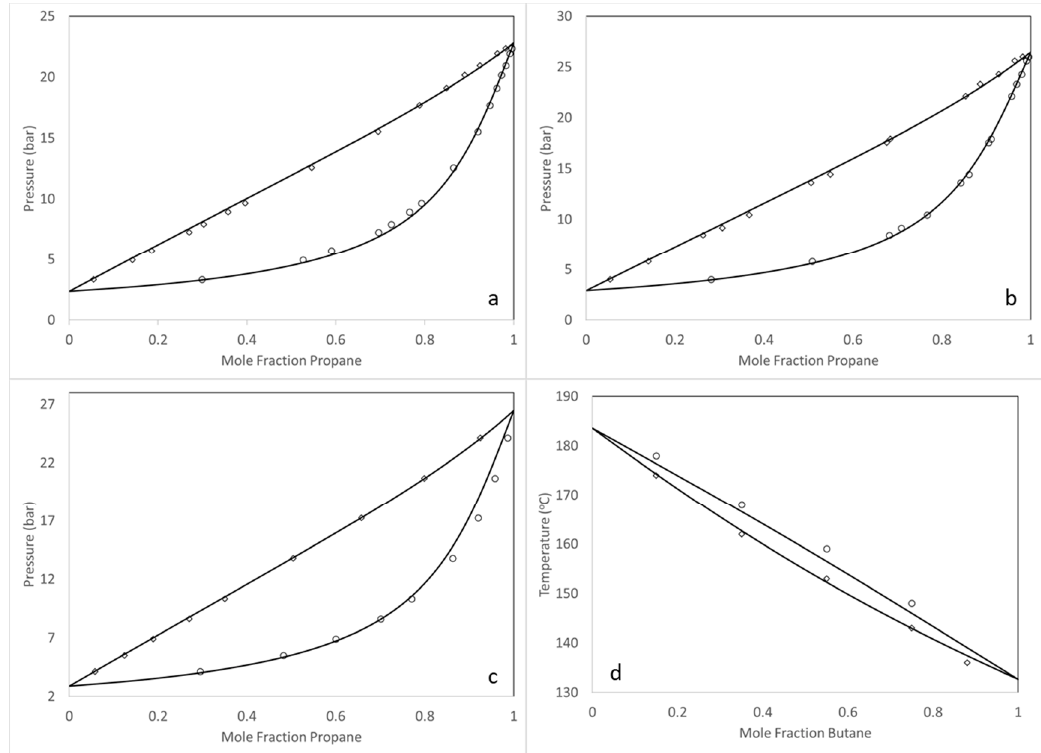
Figure 2. Vapor–liquid equilibrium data for propane/pentane and butane/pentane mixtures. Data were calculated using the Peng–Robinson EOS and the fugacity coefficient according to modified Raoult’s law. The symbols ♦ and o represent experimental data for liquid and vapor, respectively, and the line represents model predictions. ( a ) Propane/pentane at 336 K [34], ( b ) propane/pentane at 344 K [34], ( c ) propane/pentane at 344 K [35], ( d ) butane/pentane at 26.77 bar [36].